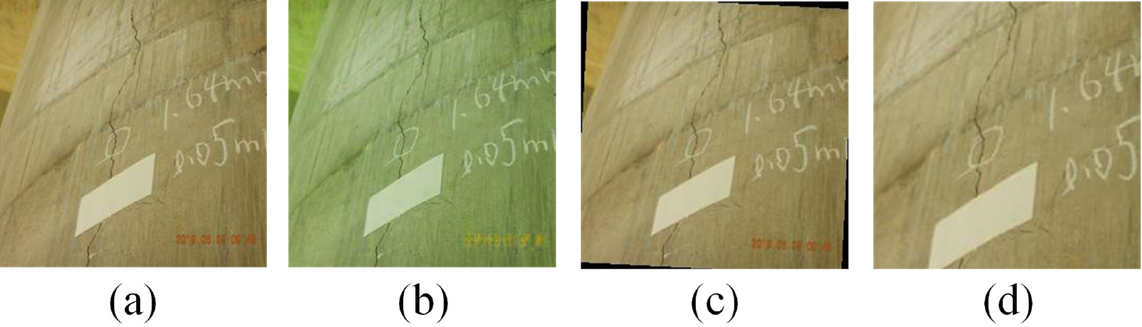
Figure 7. Data augmentation. ( a ) Original image; ( b ) color jitter augmentation; ( c ) random horizontal flip; ( d ) random scaling by 10 percent.